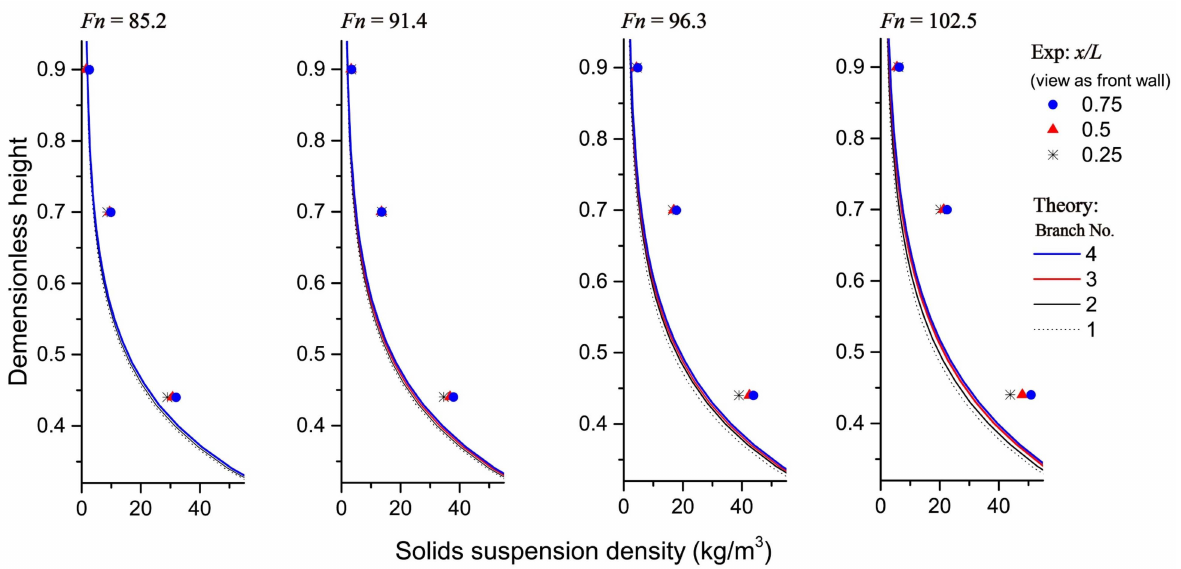
Figure 13. Effect of superficial velocity on solids suspension density (C-type